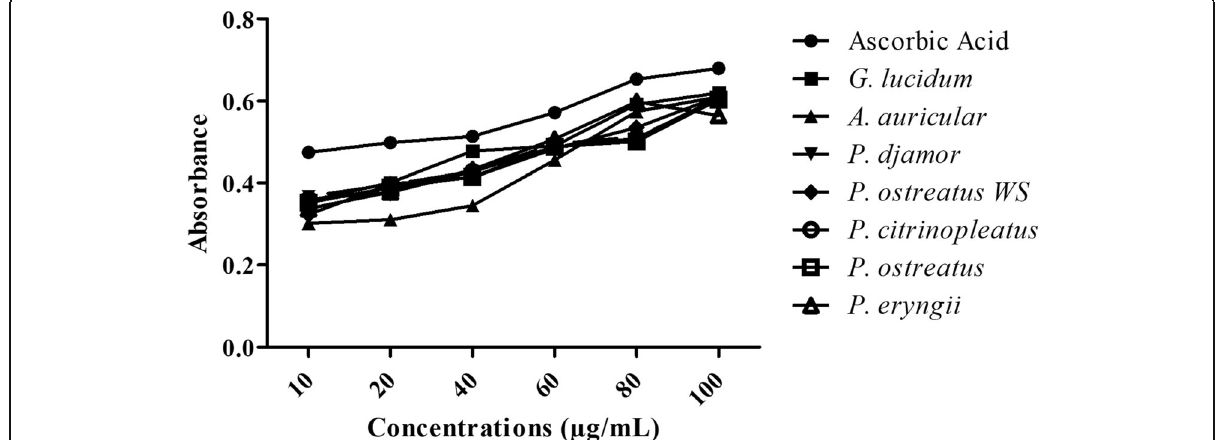
Fig. 1 Reducing power ability of the collected mushroom extracts, where the absorbance is plotted against concentration of extract. [Values are mean ± SD ( n =